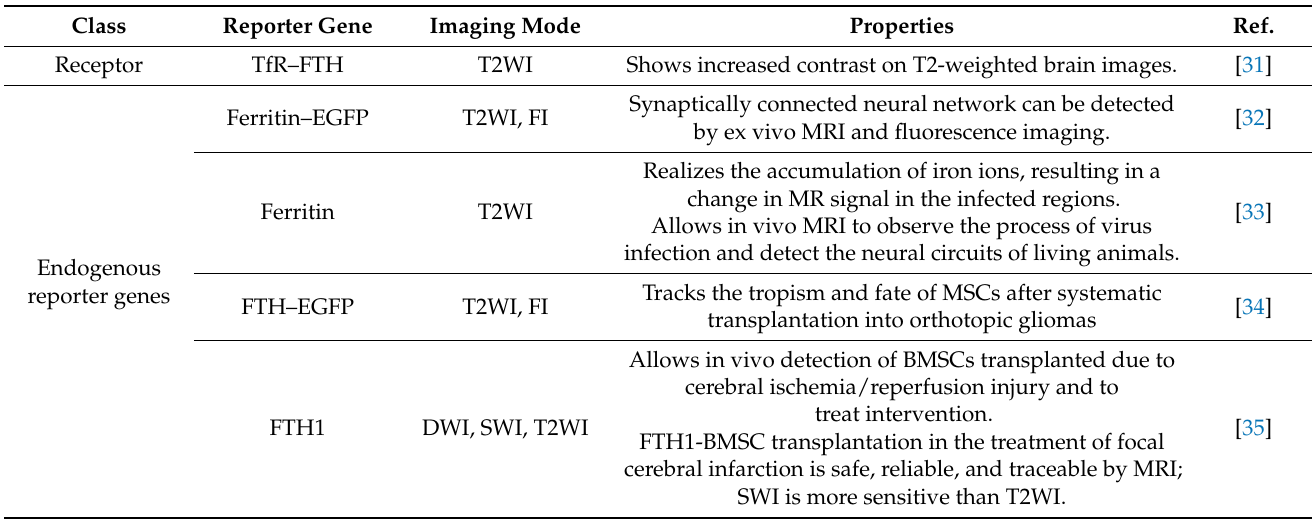
Table 2. Reporter genes in brain imaging of